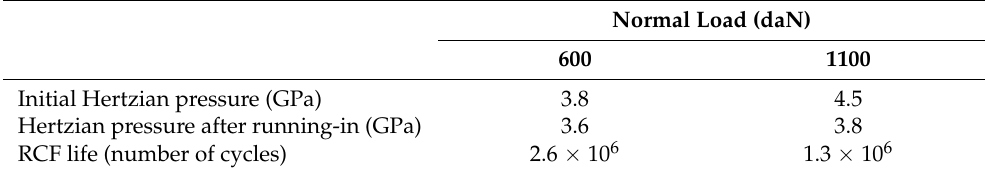
Table 2. Hertizian pressure variations after running-in and RCF life of rings finished by grinding.